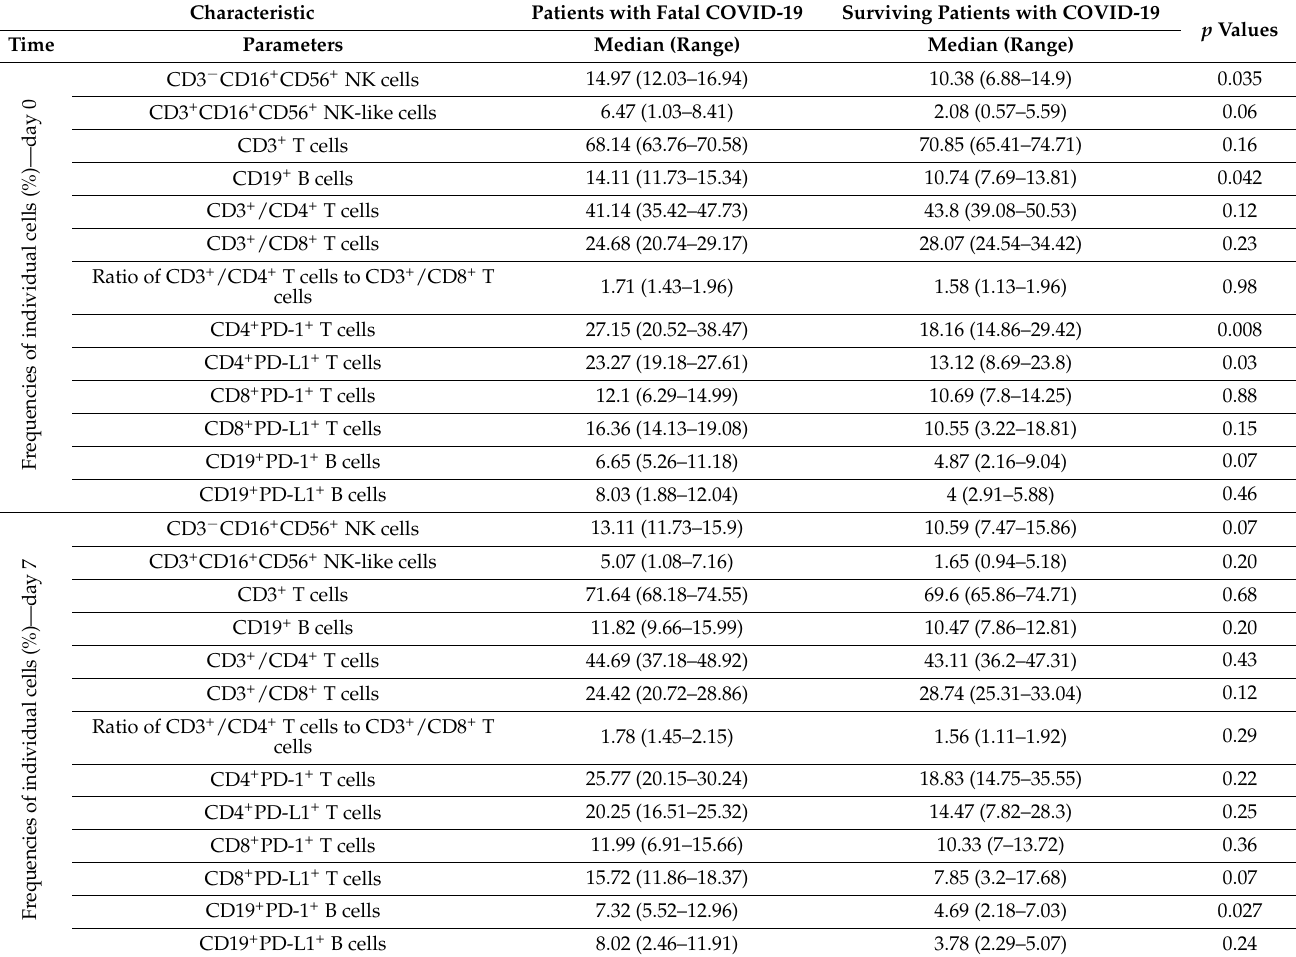
Table 5. Comparison of selected immunophenotype parameters between surviving patients with COVID-19 and patients with fatal